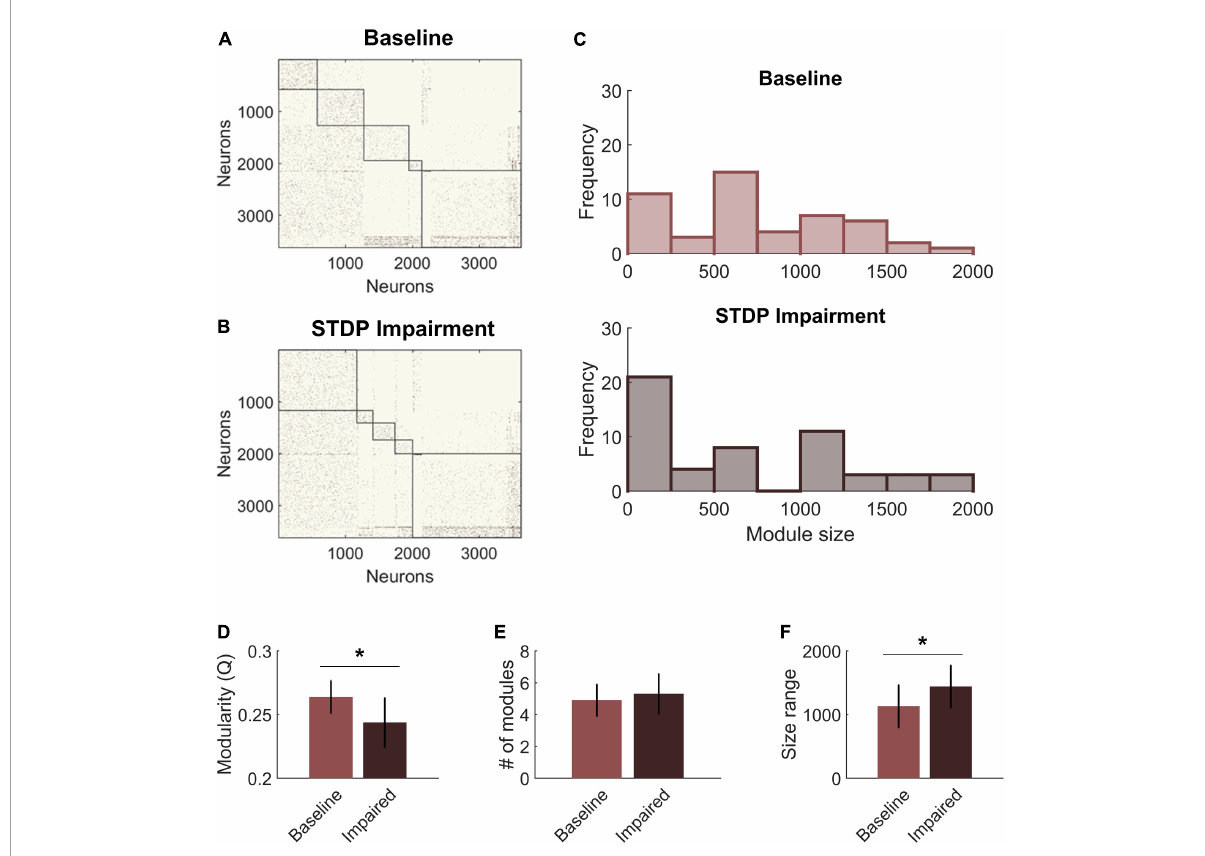
FIGURE4 Spike-timing-dependent plasticity (STDP) impairment decreases modularity in the CA3-CA1 network. (A) A representative network organized by community assignment shows five modules at baseline. (B) The same representative network has five communities after STDP impairment, but individual node assignments can change resulting in different module size characteristics. (C) Histograms of module size across all 10 networks show that there are more modules at the extreme ends of the size range after STDP impairment. (D) Module quality Q decreased significantly with injury (* p < 0.01). (E) The average number of modules per network did not change after injury. (F) The range of module size increased significantly after injury (* p <